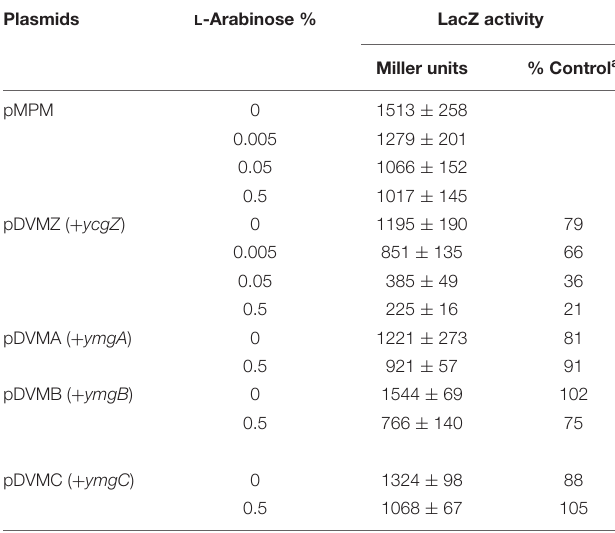
TABLE 2 | Expression of P ompF-lacZ in E. coli VDL104 ( lon bluR ycgZ-ymgABC ) grown to exponential phase in LB medium at 25 ◦ C.